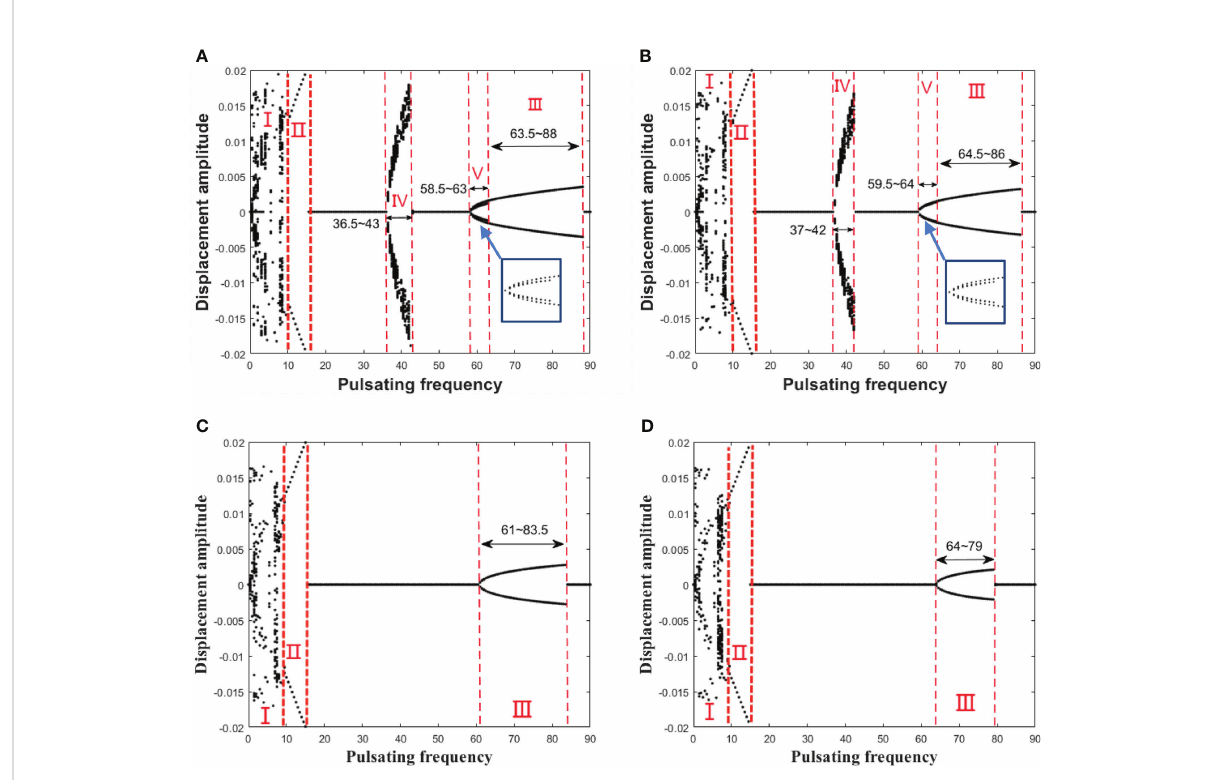
FIGURE 17 The bifurcation diagrams for the midpoint of the pipe with different Kelvin – Voigt damping a (in which u = 2, υ = 2, m = 0.6, and the control parameter is the pulsating frequency w p ). (A) a = 0.002; (B) a = 0.004; (C) a = 0.006; (D) a = 0.008.